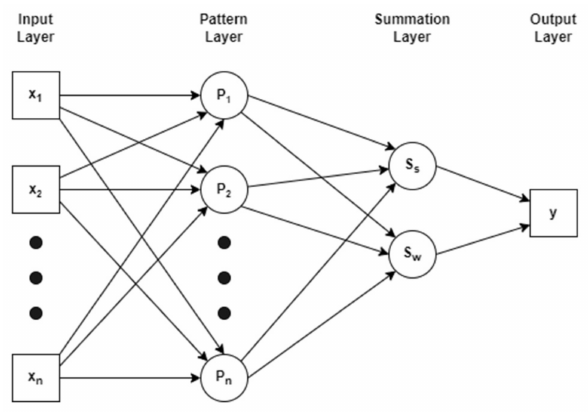
Figure 5. The architecture of General Regression Neural